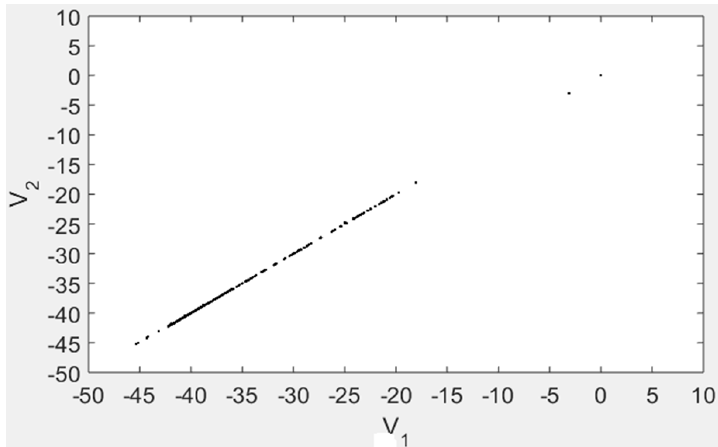
Figure 4. Locus (V1, V2) when H syn = 0.8.